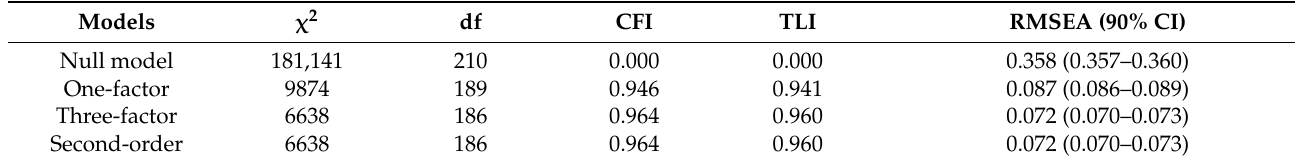
Table 4. Confirmatory Factor Analysis (CFA) of the DASS and the Factor Loadings.